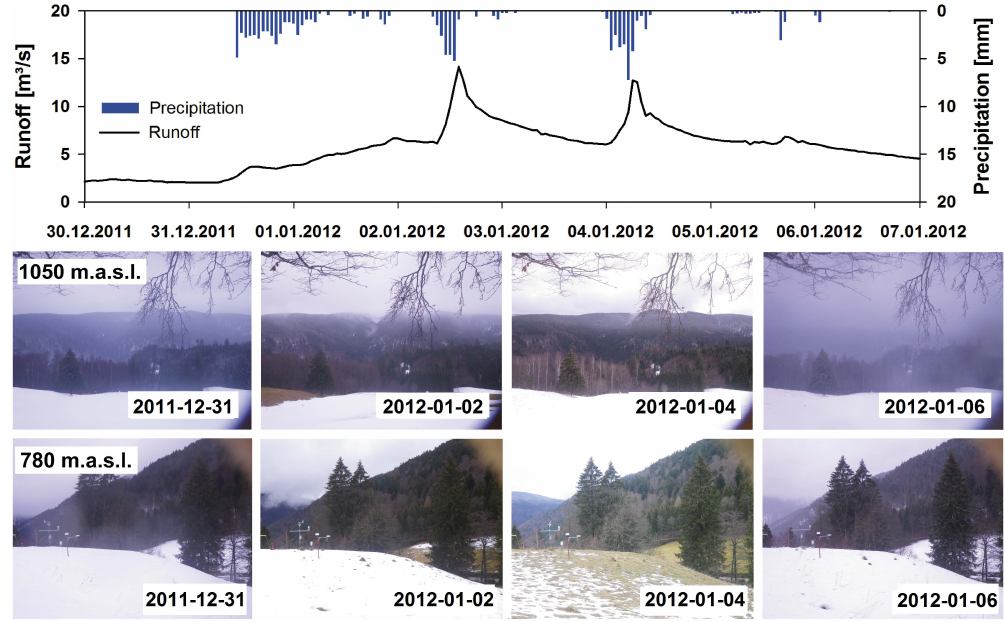
Fig. 8. Hydrograph, precipitation and time lapse photographs for the Brugga basin for three runoff events at the beginning of January 2012.